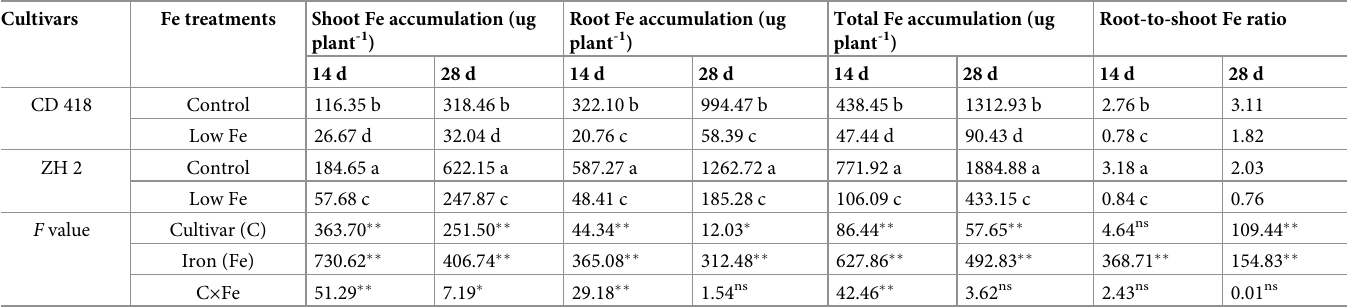
Table 2. Fe accumulation of maize seedlings grown under different Fe concentrations.